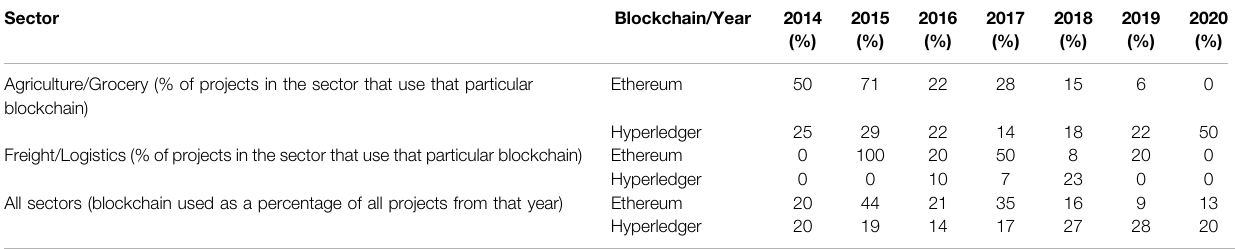
TABLE 4 | Comparison of Ethereum and Hyperledger projects in the Agriculture/Grocery and Freight/Logistics sectors over time a .